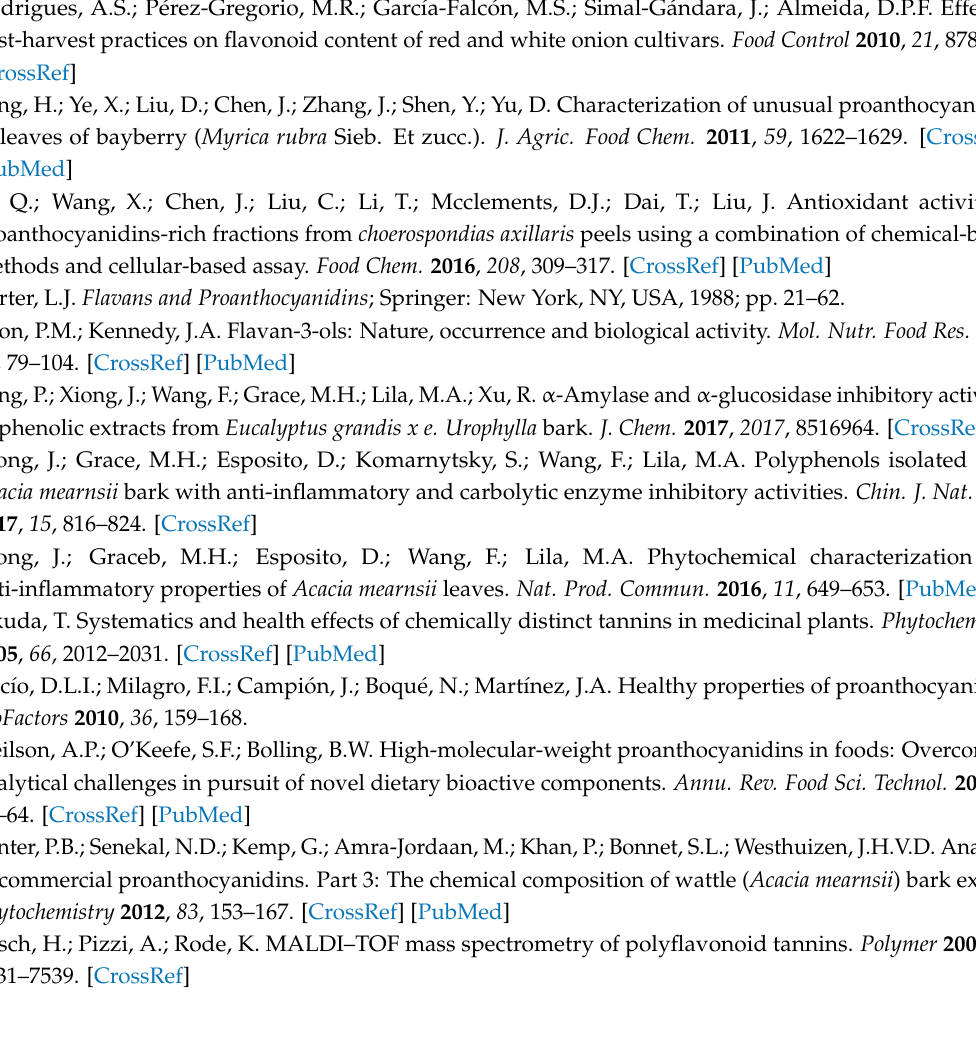
Supplementary Materials: The following are available online, Figure S1: Mass spectrometry and proposed compounds of PAs from A. mearnsii bark under different retention times. Figure S2: MALDI-TOF positive reflectron mode mass spectra of ABE: full spectrum (A), details of the 500–1000 m/z (B), 1100–1900 m/z (C), and 2000–3600 m/z